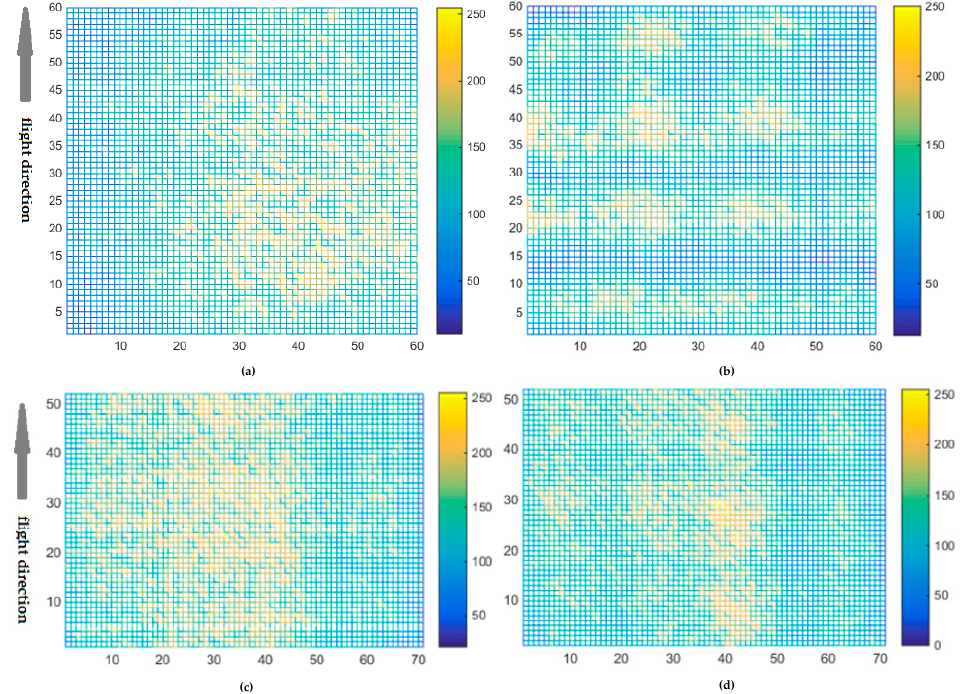
Figure 13. Comparison of the tie point distribution in different study areas. ( a ) Yuyao; ( b ) Baoding; ( c ) Zhang Jiakou block1; ( d ) Zhang Jiakou block2.